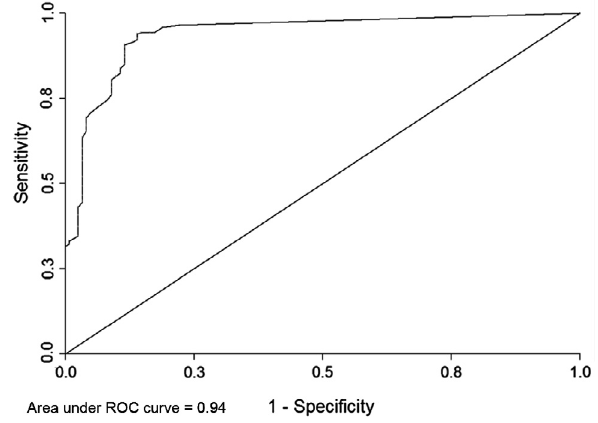
Figure 1. Receiver operating characteristic curve for 384 IgG negative (<6 UI/mL) or equivocal sera (6–9 UI/mL).